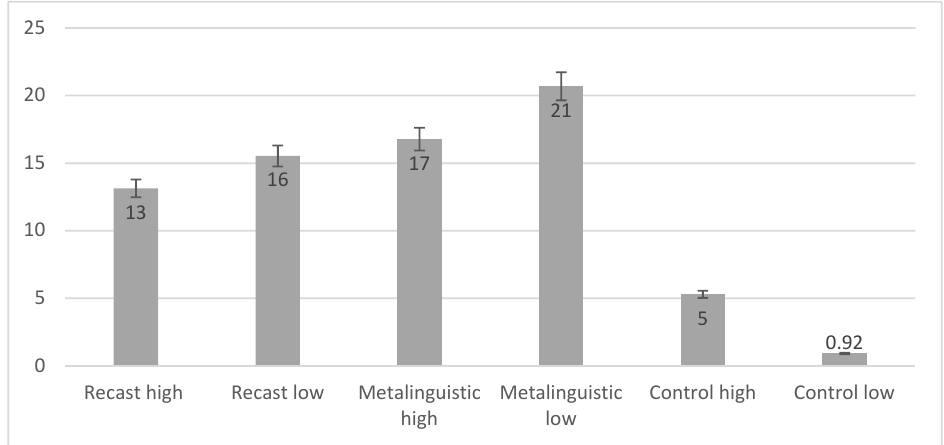
Figure 3. Percent variance of students’ scores in each group based on their proficiency.